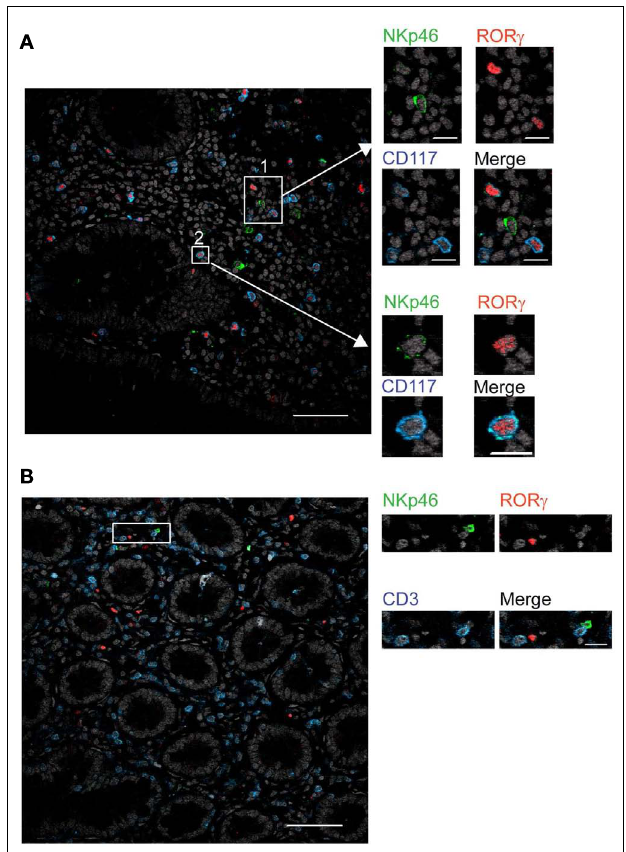
FIGURE 6 | ROR γ t + cells in the gut express low cell surface density of NKp46. (A,B) Frozen sections of human colon were stained with (A) polyclonal anti-NKp46 serum (green), anti-ROR γ t mAb (red), and anti-CD117 mAb (blue) or with (B) polyclonal anti-NKp46 serum (green), anti-ROR γ t mAb (red), and anti-CD3 mAb (blue). Nuclei were counterstained with Sytox (gray). Scale bar = 50 µ m. Data are representative of at least three independent experiments performed on three distinct